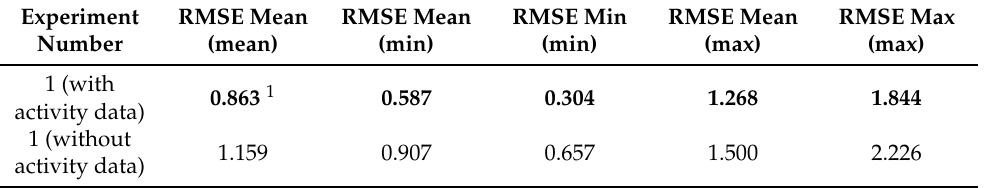
Table 7. Obtained results for experiment 1 with and without activity data in mmol/L.